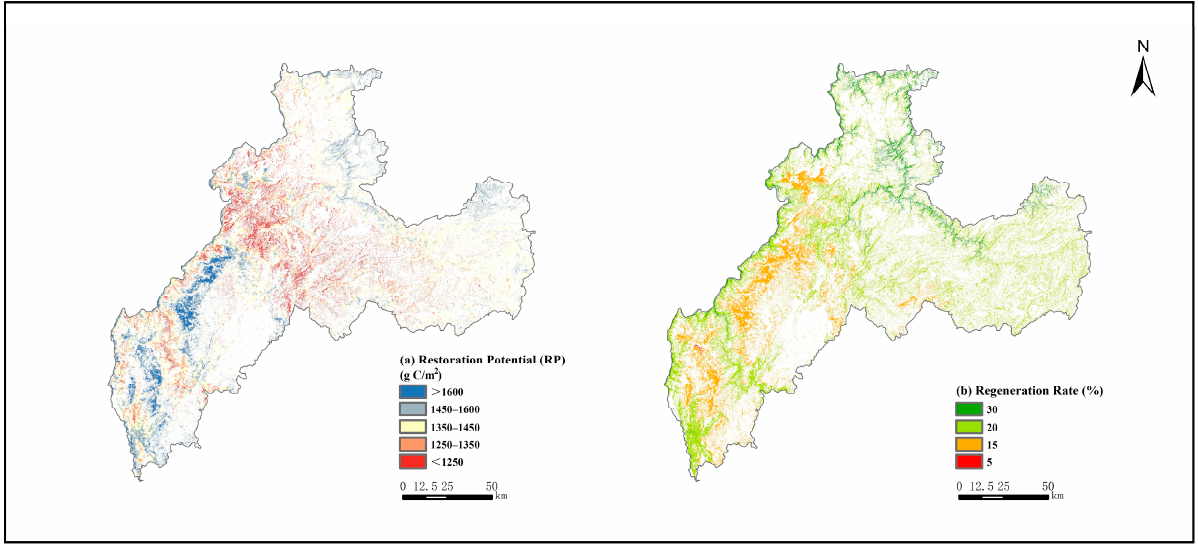
Figure 7. ( a ) Maps of grassland restoration potential ( b ) and grassland regrowth rate in Zhaotong. The distribution map of estimated grassland RP in Zhaotong is shown in Figure 7a.